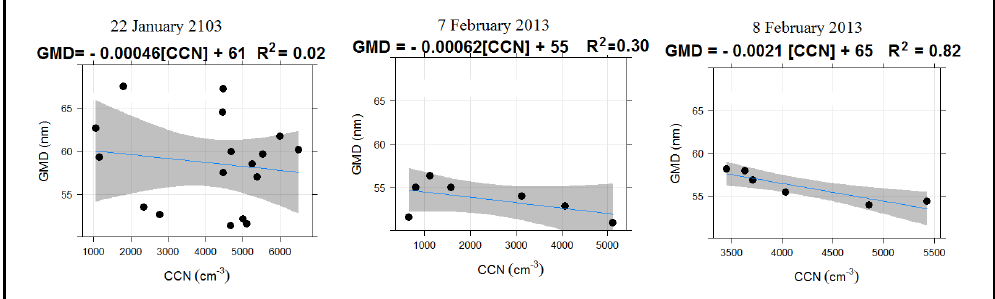
Figure 11. Relationship of cloud condensation nuclei (CCN) and geometric mean diameter (GMD) for particles that are equal to and larger than 50 nm observed during the relevant time of Class I particle formation events. The shaded area is the 95% confidence level. 6 February 2013 was not included due to the fact that the observed GMDs on this day were less than 50 nm. Ten-minute averaged data were